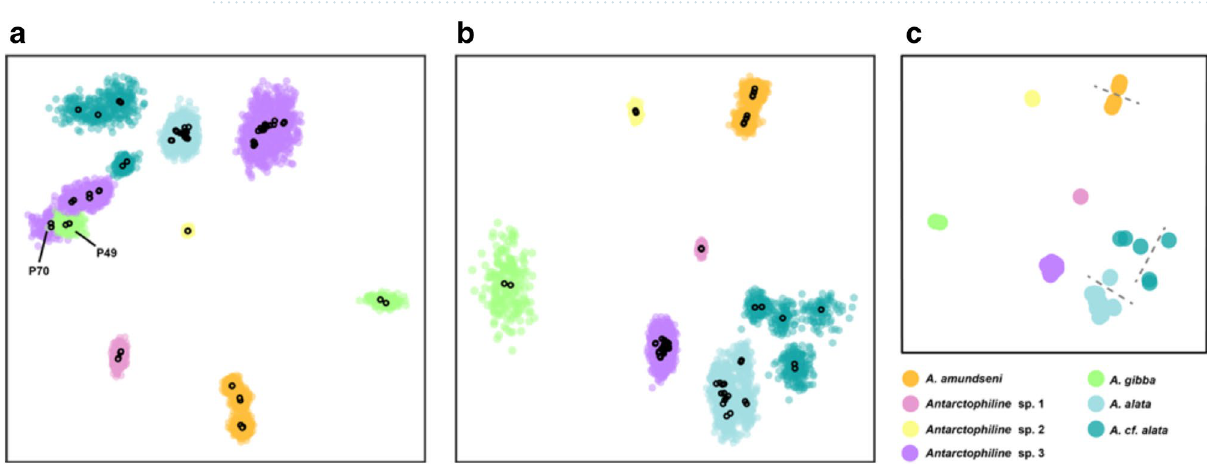
Figure 3. Variational autoencoder (VAE) showing two haplotypes (circles) per sample and clustering results. ( A ) VAE output on the full dataset with a mean (black outlined circle) and standard deviation (colored circles) for each sample. ( B ) VAE output on the dataset with P49 and P70 removed. ( C ) Results of PAM and hierarchical clustering analyses on the VAE output of the dataset with P49 and P70 removed, favoring seven clusters. Dashed lines indicate further split clusters recovered with the gap